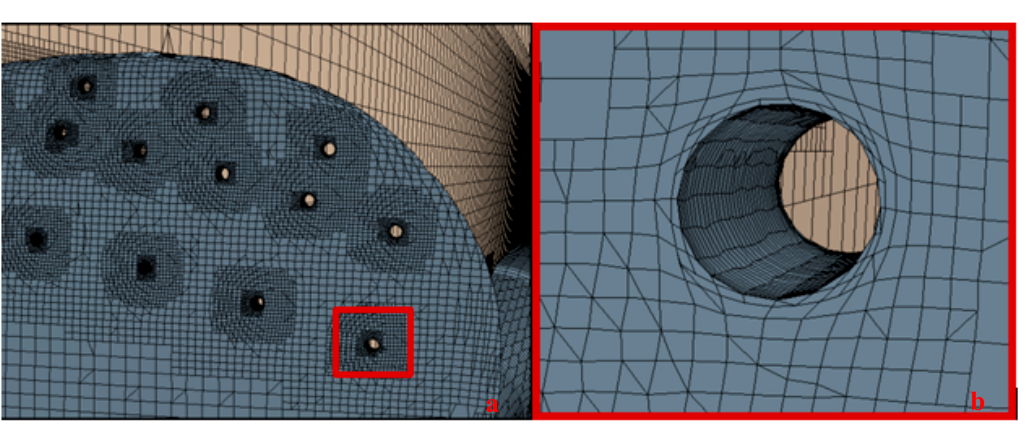
Figure 22. Local drilled hole refinements for capturing accurate flow through the holes ( a ) Left; Propeller tip, ( b ) Right; Zoom to the hole.